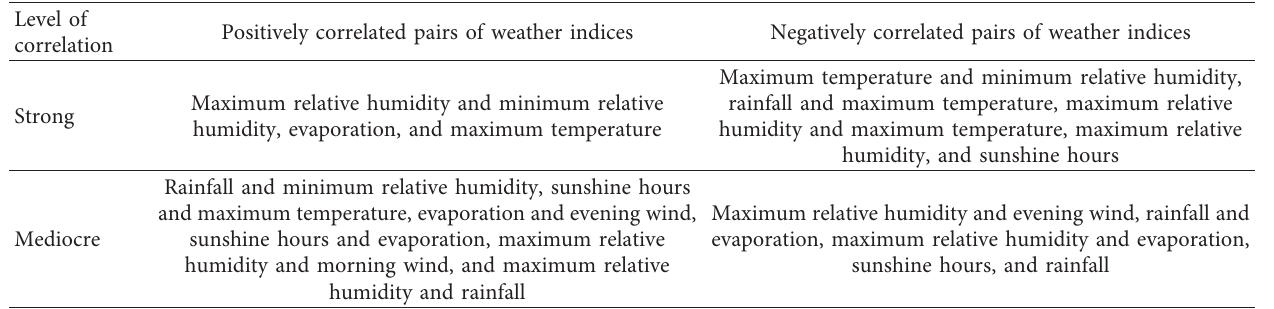
Figure 4: Distribution of maximum temperature data: (a) linear relationship between the maximum temperature and the paddy yield; (b) nonlinear relationship between the maximum temperature and the paddy yield; (c) normal distribution of maximum temperature data; (d) normal distribution of the dependent variable. Table 5: Correlation between the weather